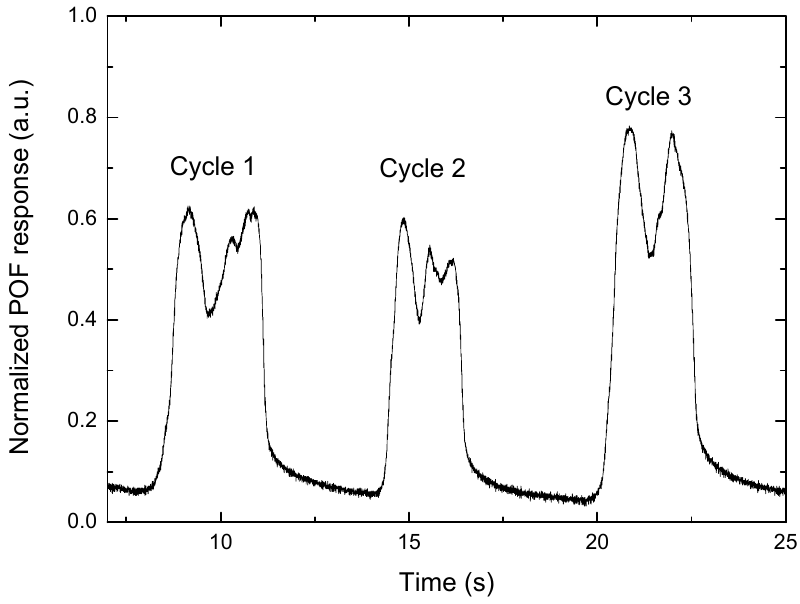
Figure 12. In-shoe monitoring of sequential gait cycles.